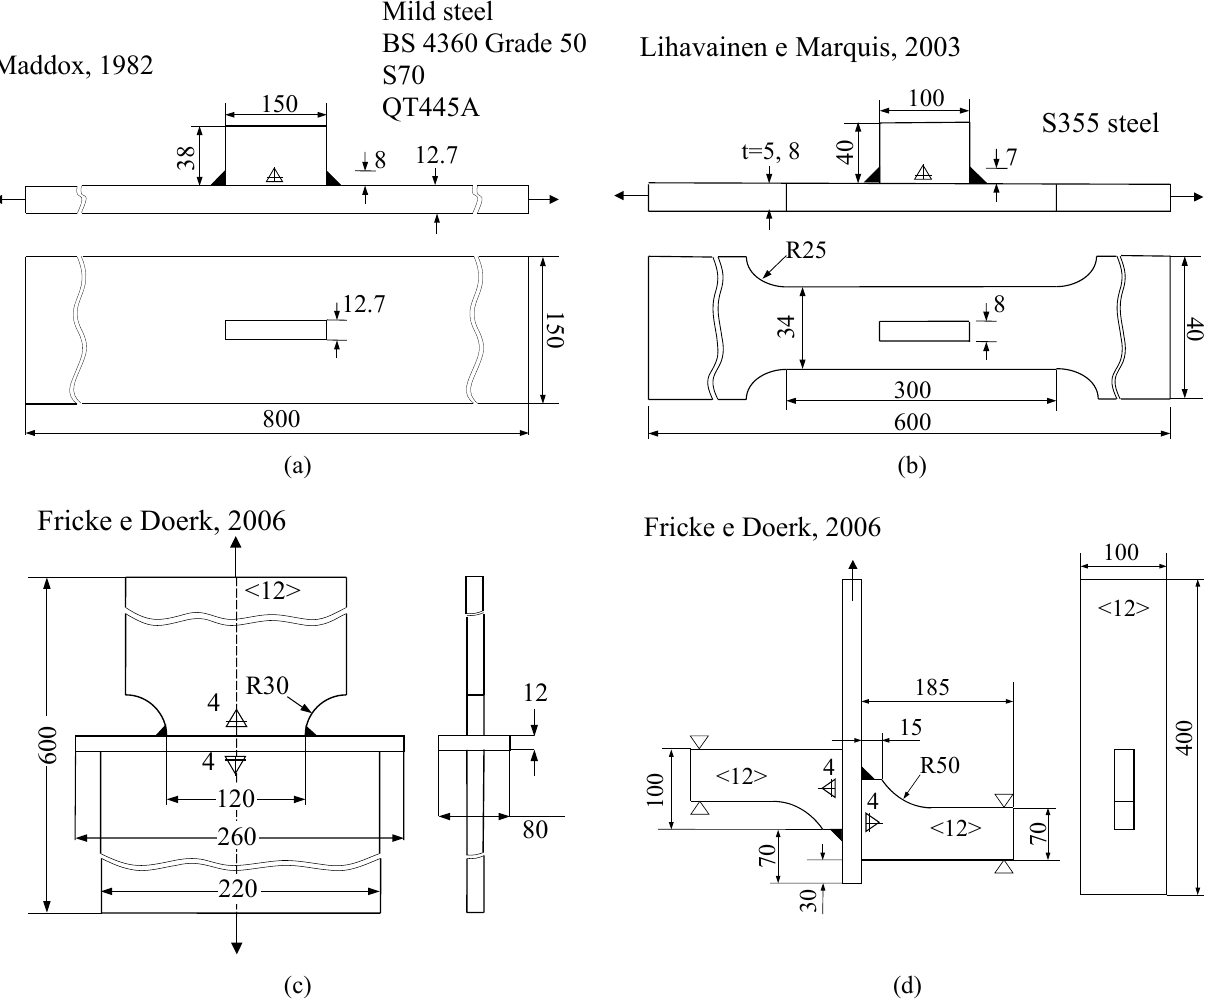
Figura 5. Geometrie dei giunti saldati analizzati. I dati originali sono relativi ai riferimenti [11-13]. Tutte le dimensioni sono in